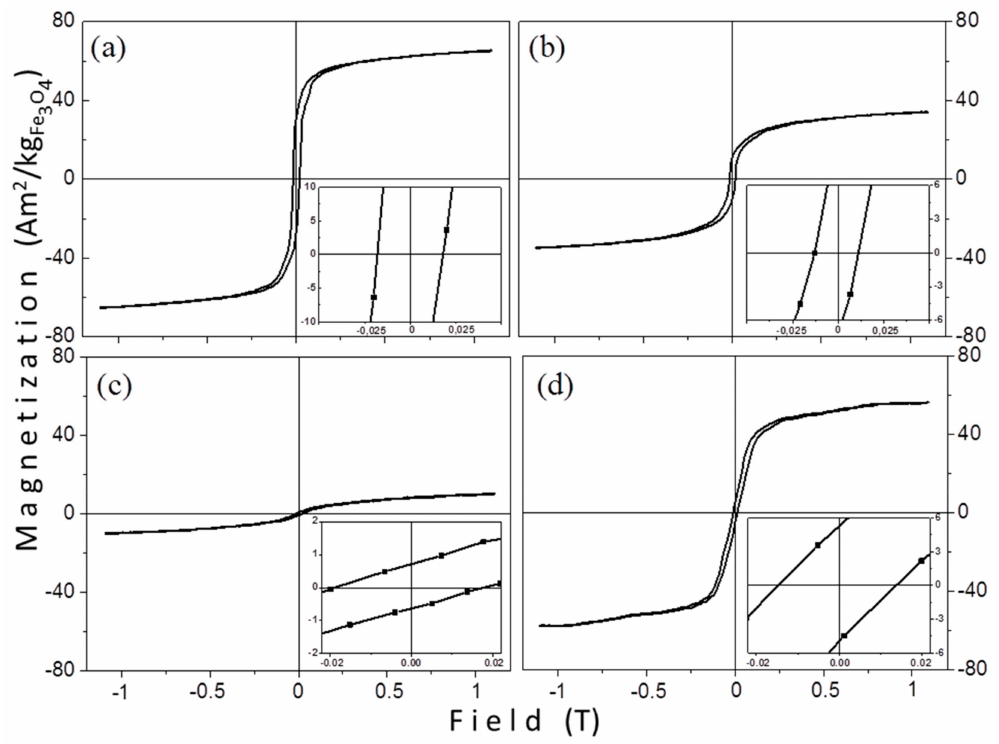
Figure 7. Room temperature hysteresis loops of samples: ( a ) TD1, ( b ) TD2, ( c ) TD3, and ( d ) TD4. The saturation magnetization values are 73.7, 66.0, 40.2, and 12.6 Am 2 / kg Fe3O4 for TD1,